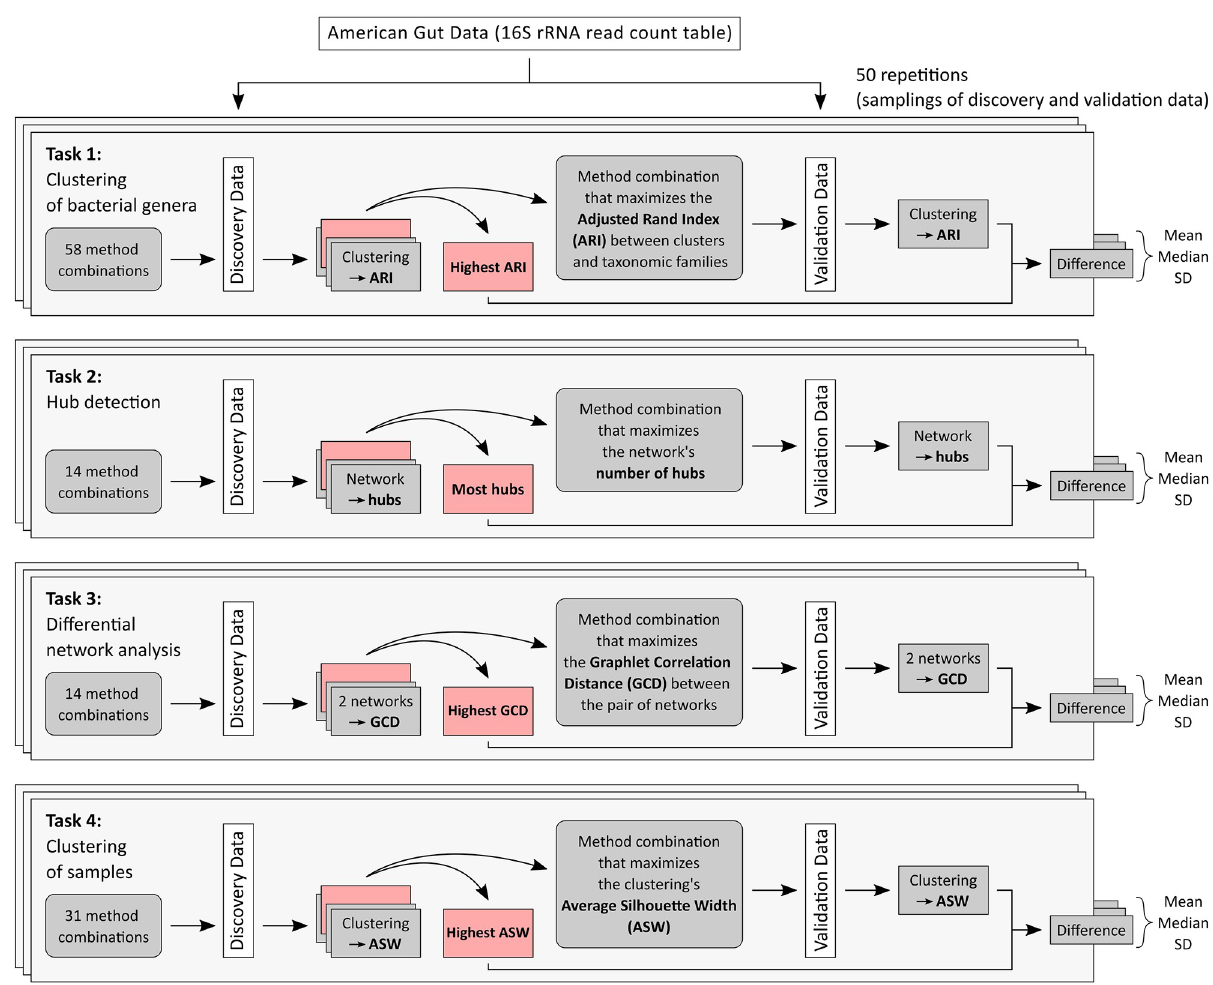
Fig 1. Graphical overview of our study. The process of drawing 50 samplings of discovery and validation data is repeated for different sample sizes: n 2 {100, 250, 500, 1000, 4000} for tasks 1 and 2, n 2 {100, 250, 500} for task 3, and n 2 {100, 250, 500, 1000, 3500} for task 4.